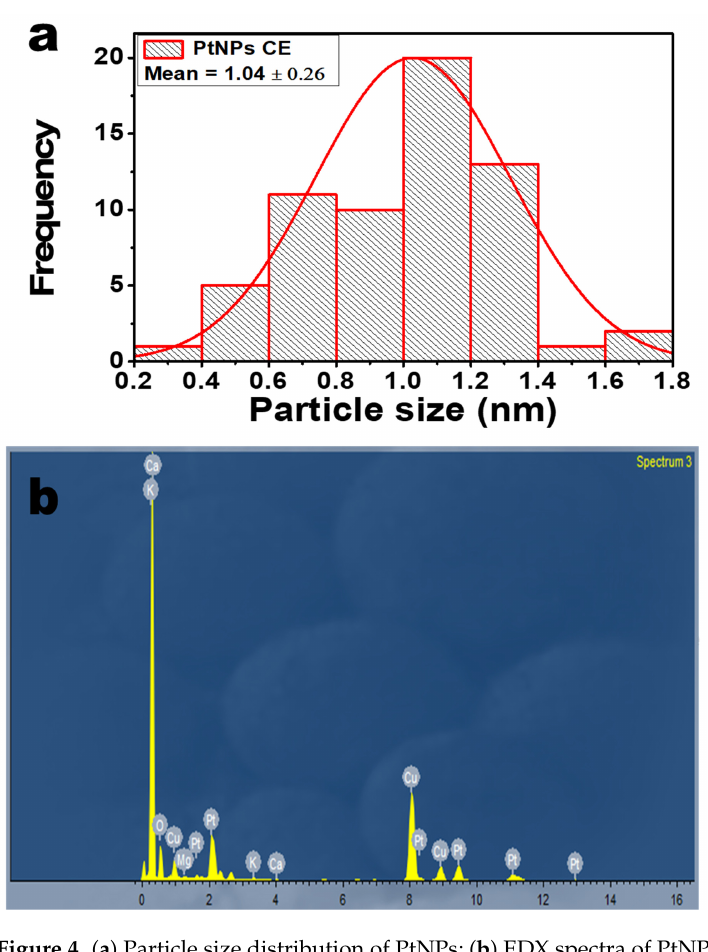
Figure 4. ( a ) Particle size distribution of PtNPs; ( b ) EDX spectra of PtNPs.